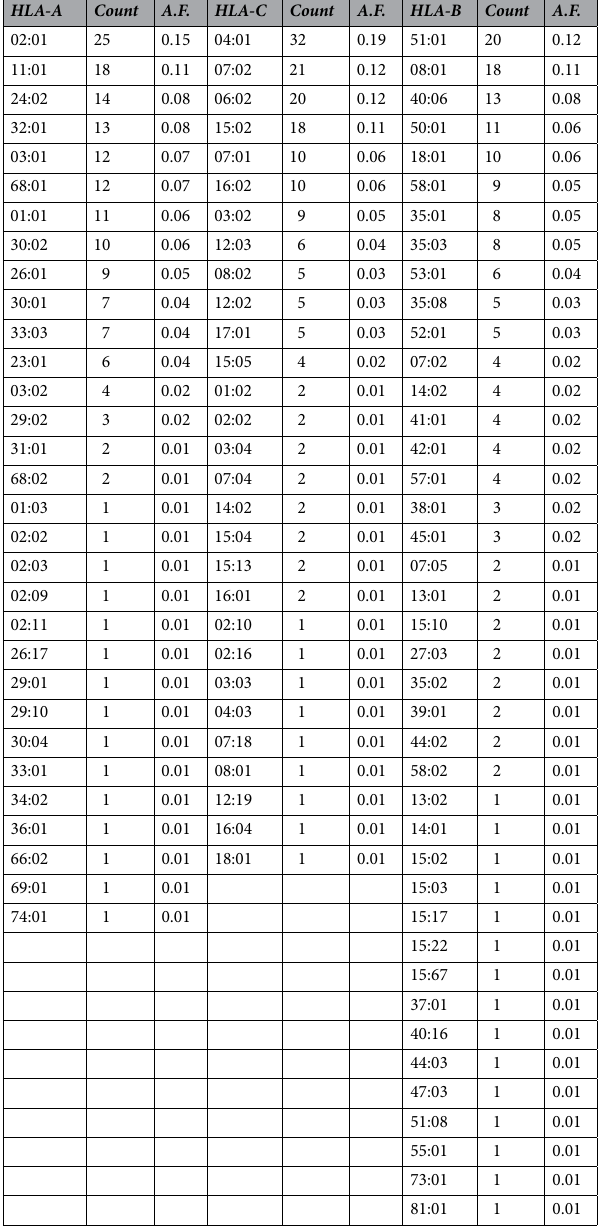
Table 1. HLA class I (HLA-A, HLA-C, HLA-B) allelic count and frequencies observed in the UAE cohort. A.F.: allele